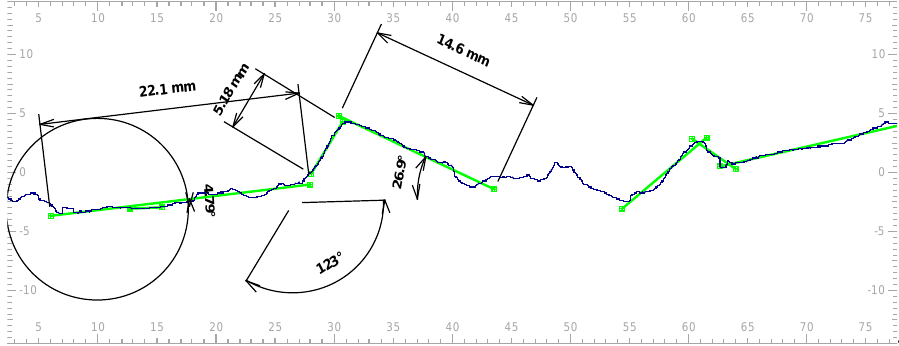
Figure 14. An example of a profile (concrete series 2) with visible parts matching the assumed generator.